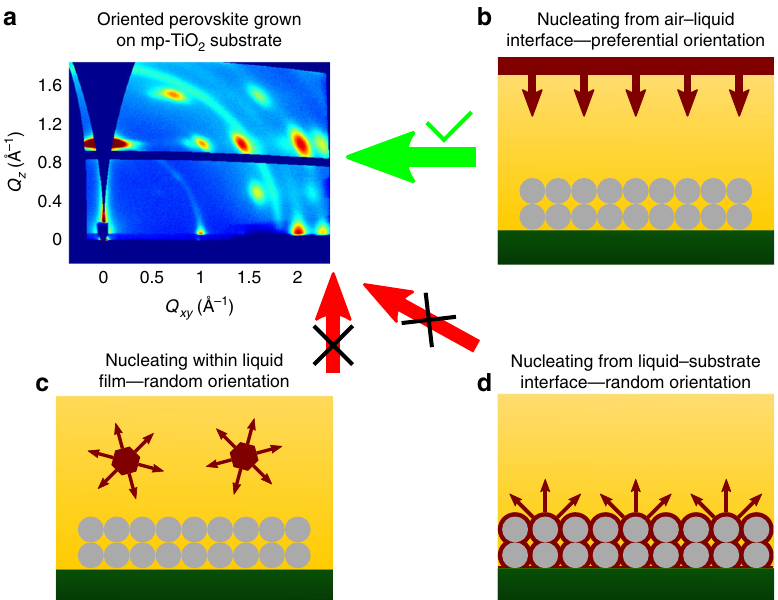
Fig. 2 Possible scenarios for nucleation with mesoporous TiO 2 substrates. a GIWAXS pattern of BA 2 MA 3 Pb 4 I 13 thin fi lm formed on mesoporous TiO 2 (mp- TiO 2 ) substrates indicates a strong vertical orientation. The continuous ring at 1.8 Å is diffraction signal from mp-TiO 2 substrate. b – d Illustration of possible crystallization processes from three different nucleation sites: liquid – air interface b , within bulk liquid c , and substrate – liquid interface d . The gray circle stacks represent mp-TiO 2 substrate, the brown species represent BA 2 MA 3 Pb 4 I 13 and the brown arrows represent the crystallization direction. With the mp-TiO 2 substrate, only the nucleation and growth from the liquid – air interface scenario is consistent with formation of a vertically oriented BA 2 MA 3 Pb 4 I 13 thin fi